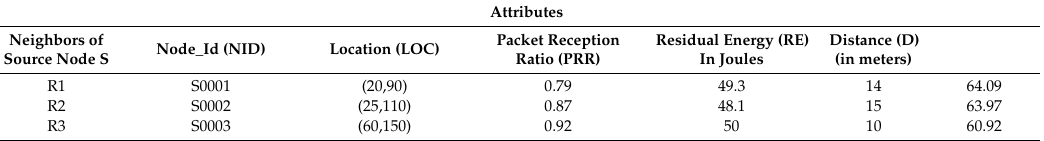
Table 4. Description of neighbors of source node S along with its